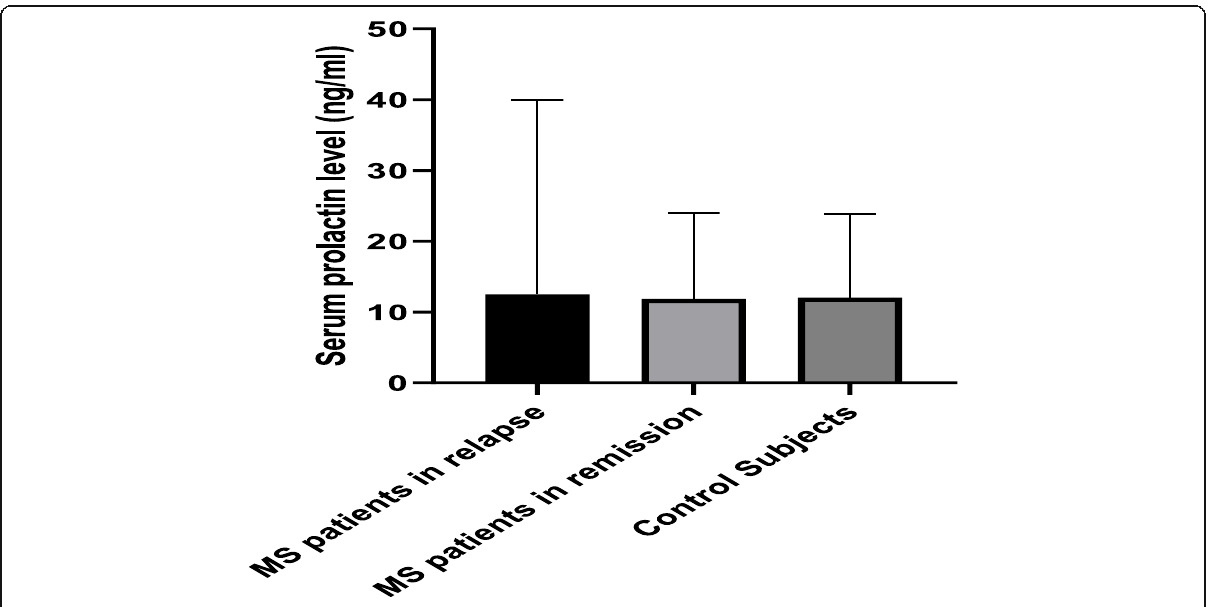
Fig. 1 Comparison of serum prolactin (PRL) level among the studied groups